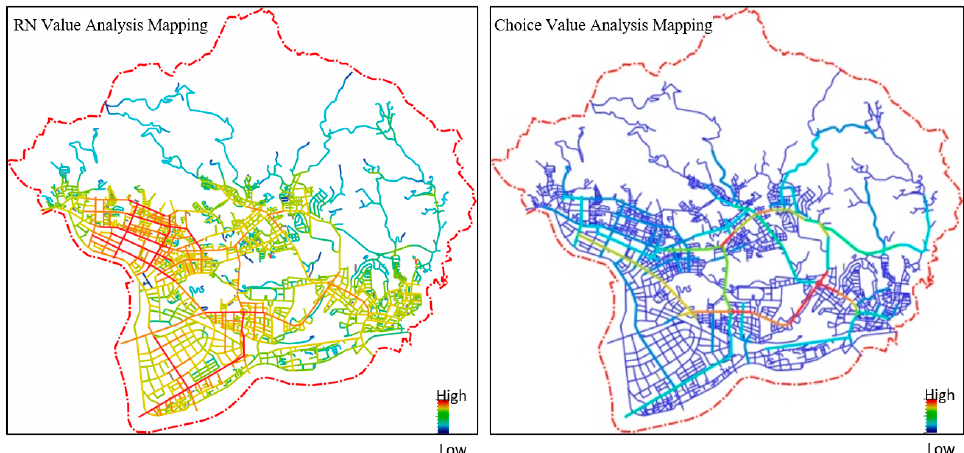
Figure 5. The whole-district axial analysis map of Nei-Hu.